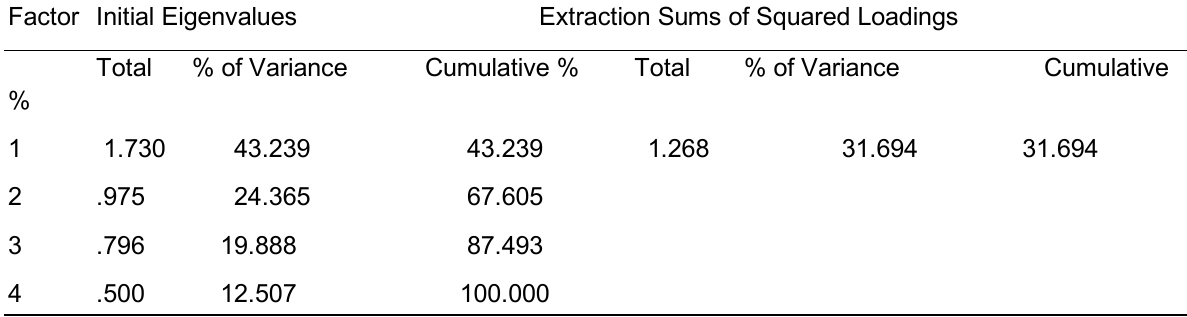
Table 2: Total Variance Explained